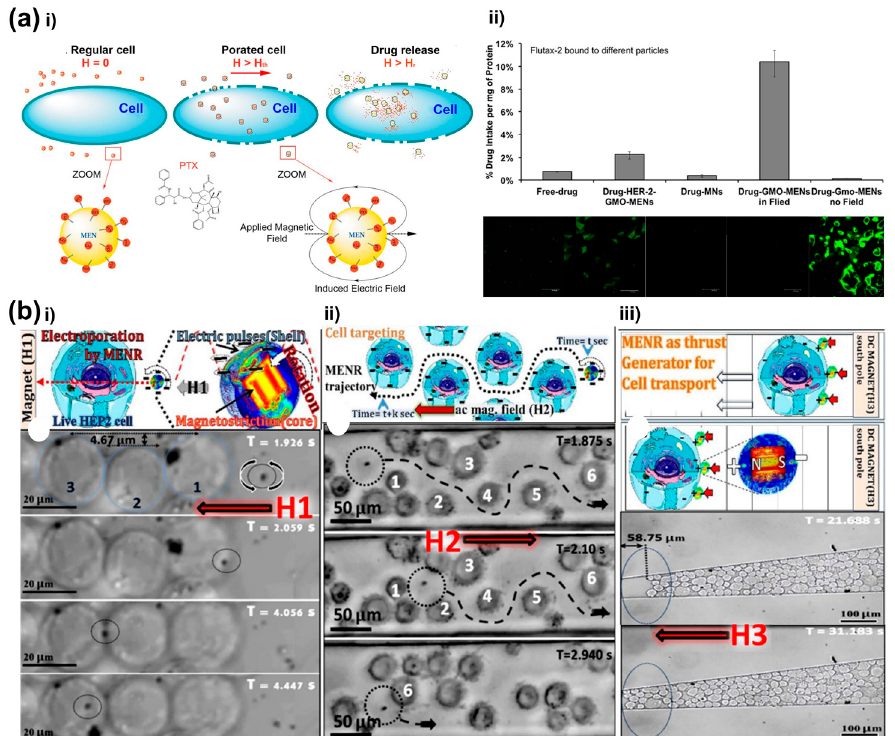
Figure 5. Schematics showing MENP-facilitated drug delivery. ( a )-(i) Drug uptake via nano electro- poration induced by the MENPs, and (ii) verification of the ME effect of MENPs on drug uptake. Reproduced with permission from [51]. Copyright 2013, Nature. ( b ) Penetration of MENPs through or into cells due to the application of a magnetic field, including (i) electroporation, (ii) cell targeting, and (iii) cell transport; the observation is conducted by Betal et al. Reproduced with permission from [89]. Copyright 2018, Nature.